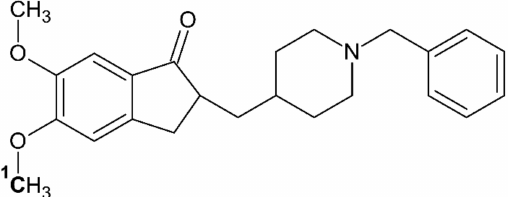
Figure 3. The chemical structure of [5- 11 C- methoxy ]donepezil, redrawn from